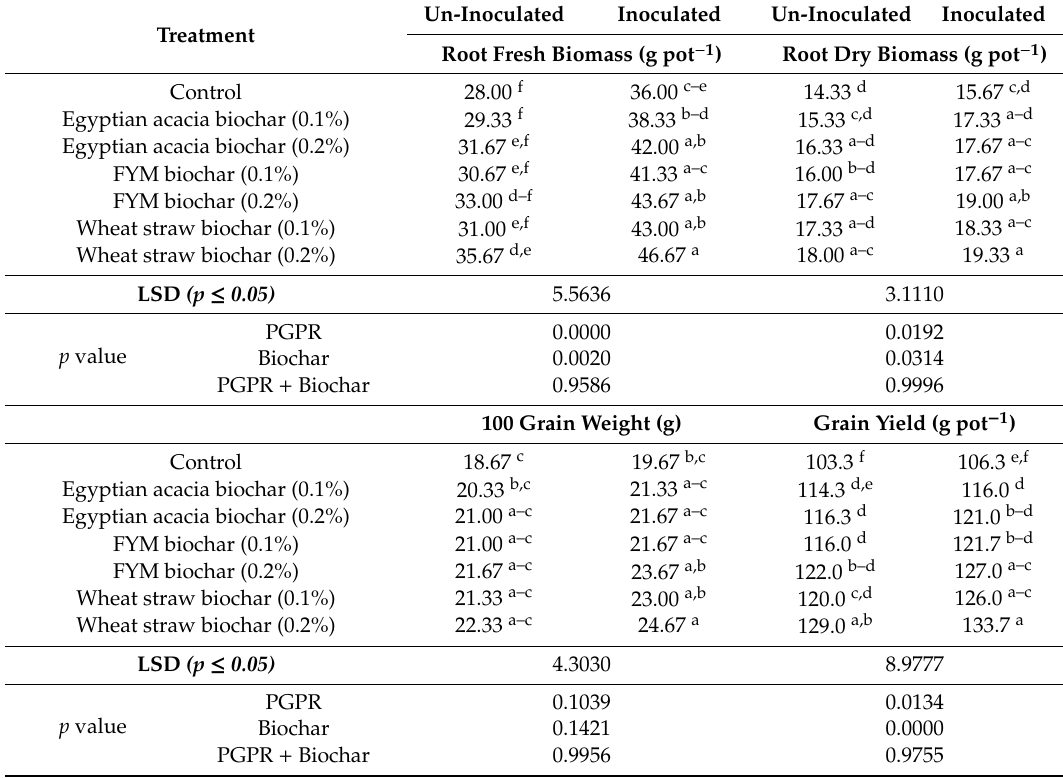
Table 3. E ff ects of biochar with and without Bacillus sp. ZM20 on root fresh biomass, root dry biomass, 100 grain weight, and grain yield of maize in pot